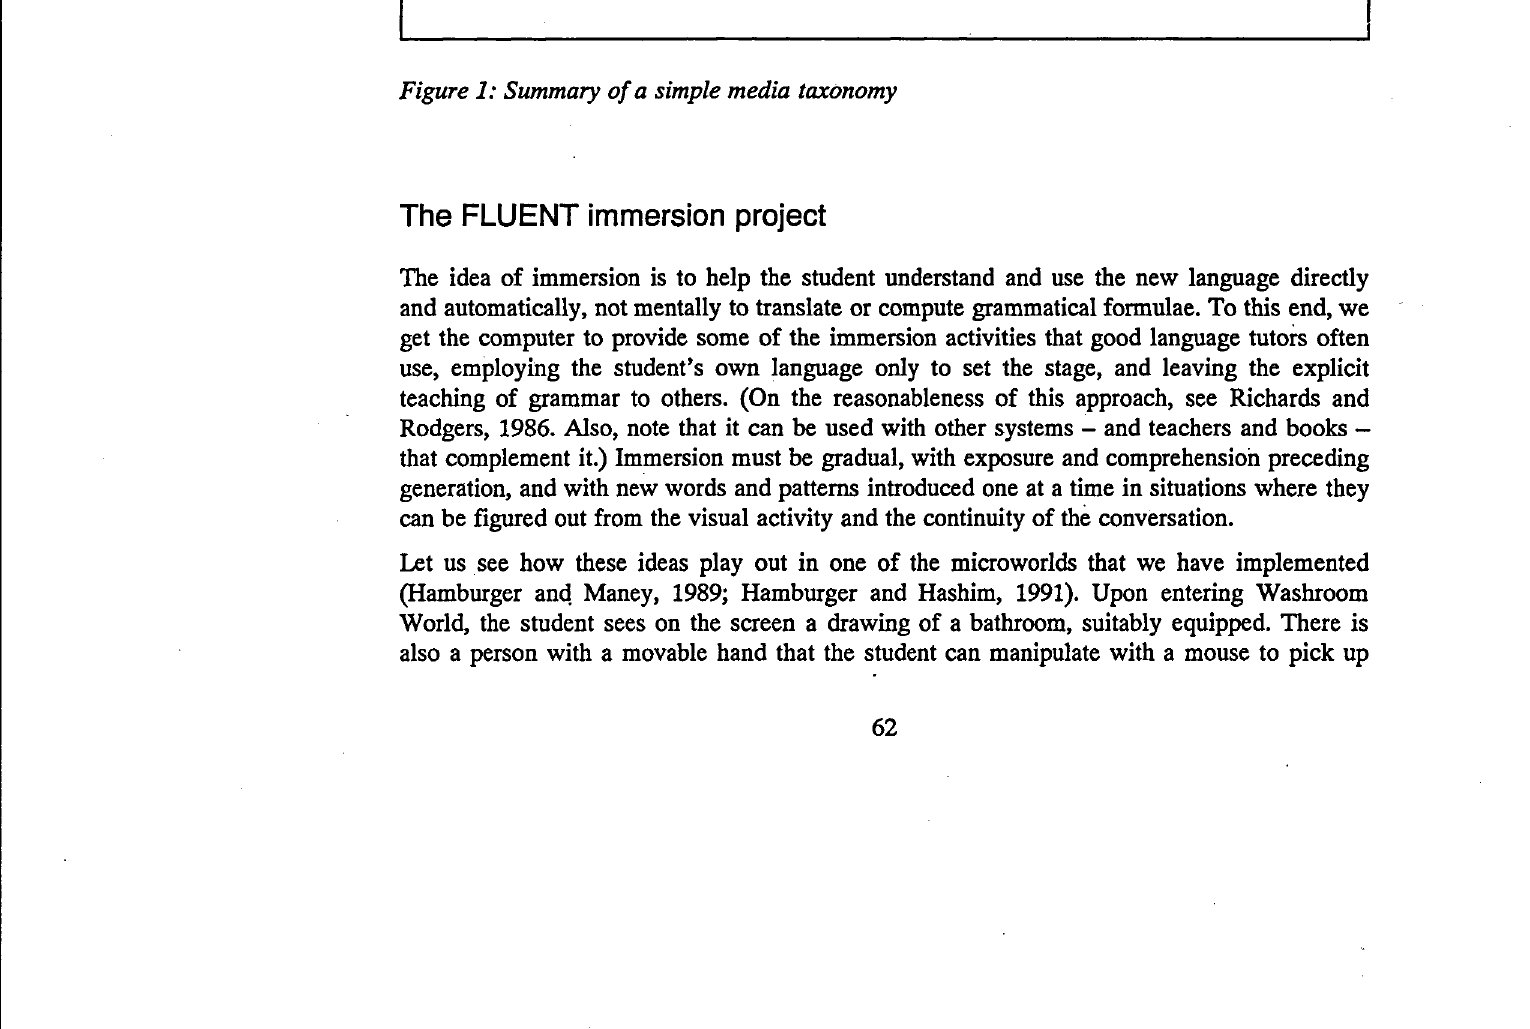
Figure 1: Summary of a simple media